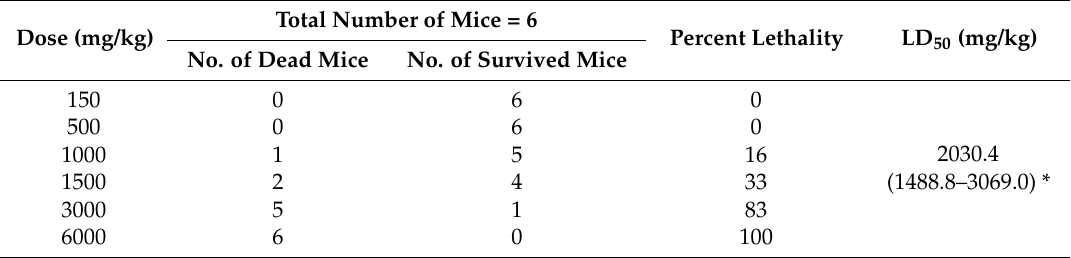
Table 1. In vivo toxicity test of Trillium govanianum rhizome methanol extract.